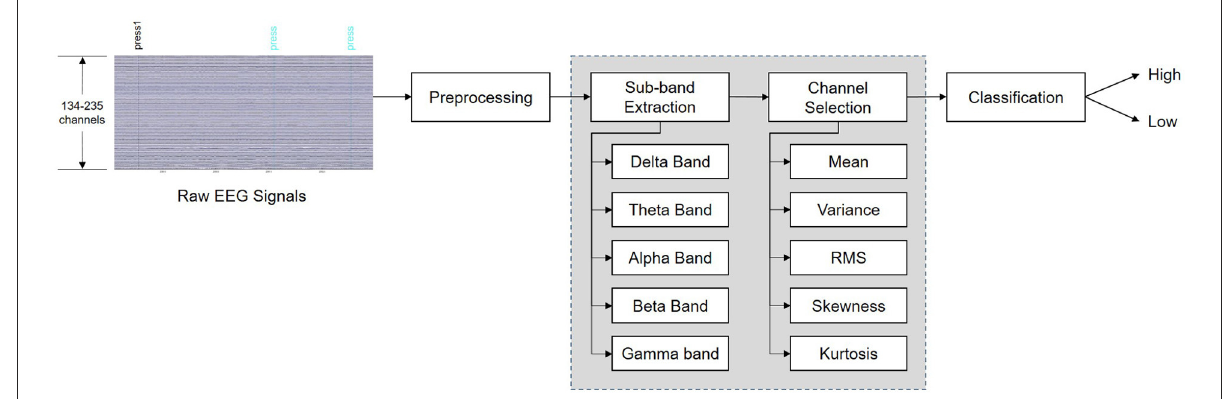
FIGURE1 Flow diagram of the proposed system for recognition of self-induced